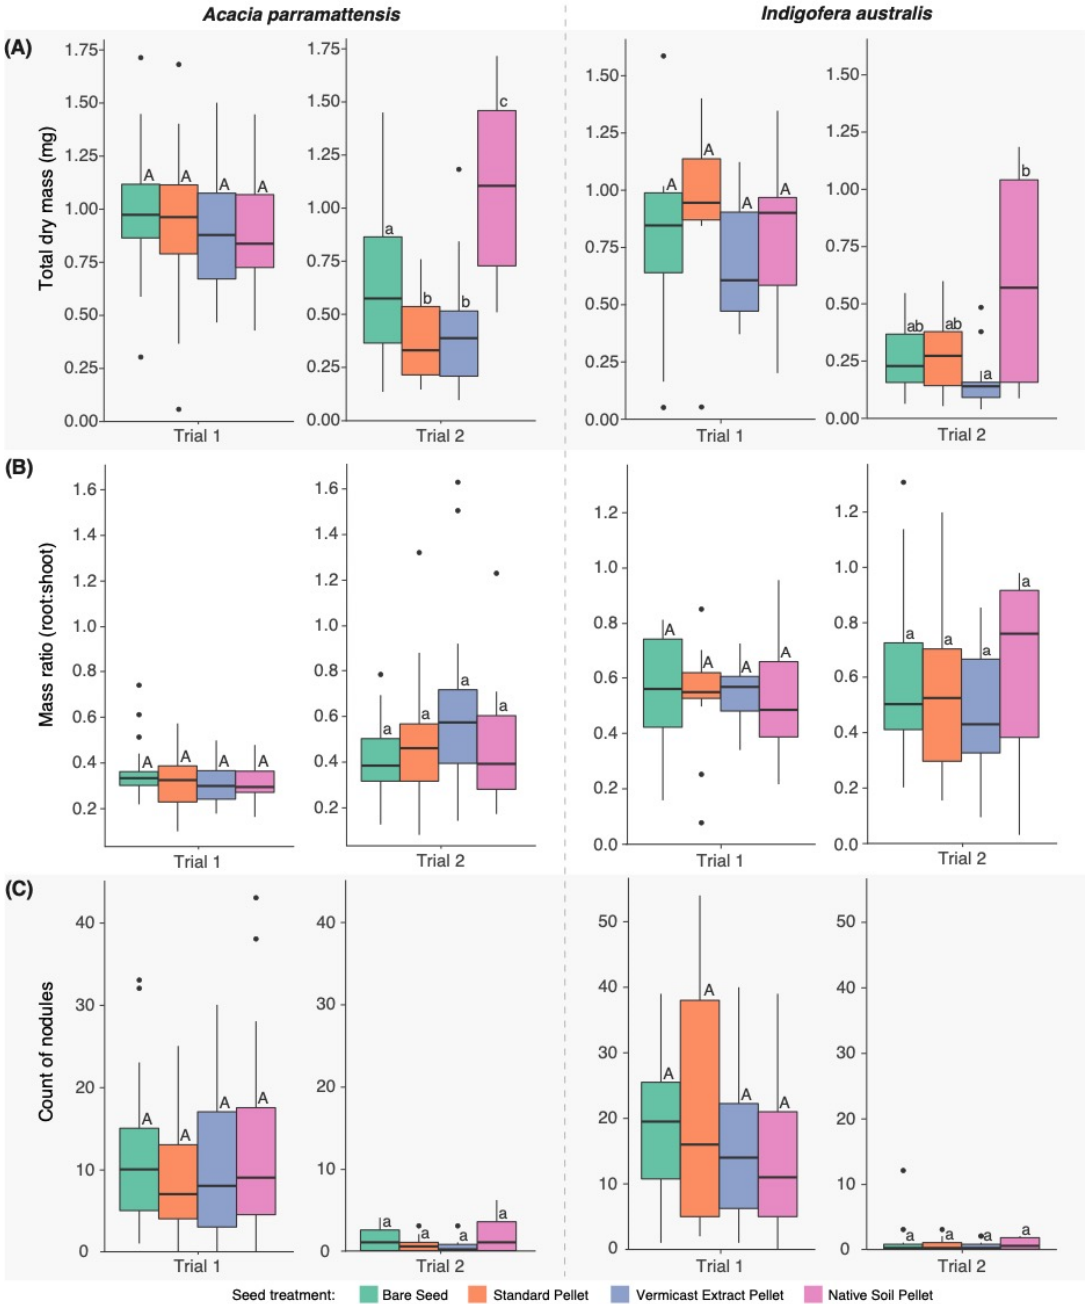
Figure 4. ( A ) Total biomass (mg) of plants, ( B ) ratios of root dry weight (mg) to shoot dry weight (mg), and ( C ) count of nodules per plant at harvest in four seed treatments. Means without shared letters differ at p < 0.05 (ANOVA and Tukey test) within species and trials (upper- vs. lower-case